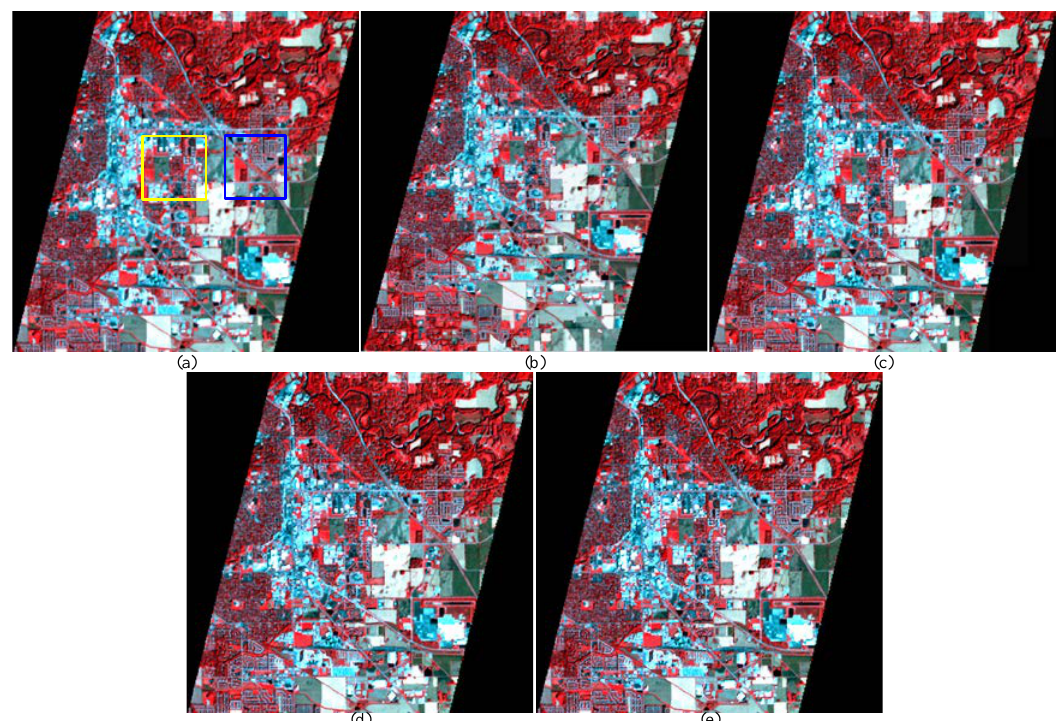
Figure 12. False color composite (band 45, 21, 14) of different Hyperion SR results. The upscaling factor is two, the size of the enhanced image is 682 × 780 with 15 m resolution. ( a ) result of Bicubic, ( b ) result of SSGS [27], ( c ) result of SRCNN [40], ( d ) result of 3D-CNN [32], and ( e ) result of MW-3D- CNN.